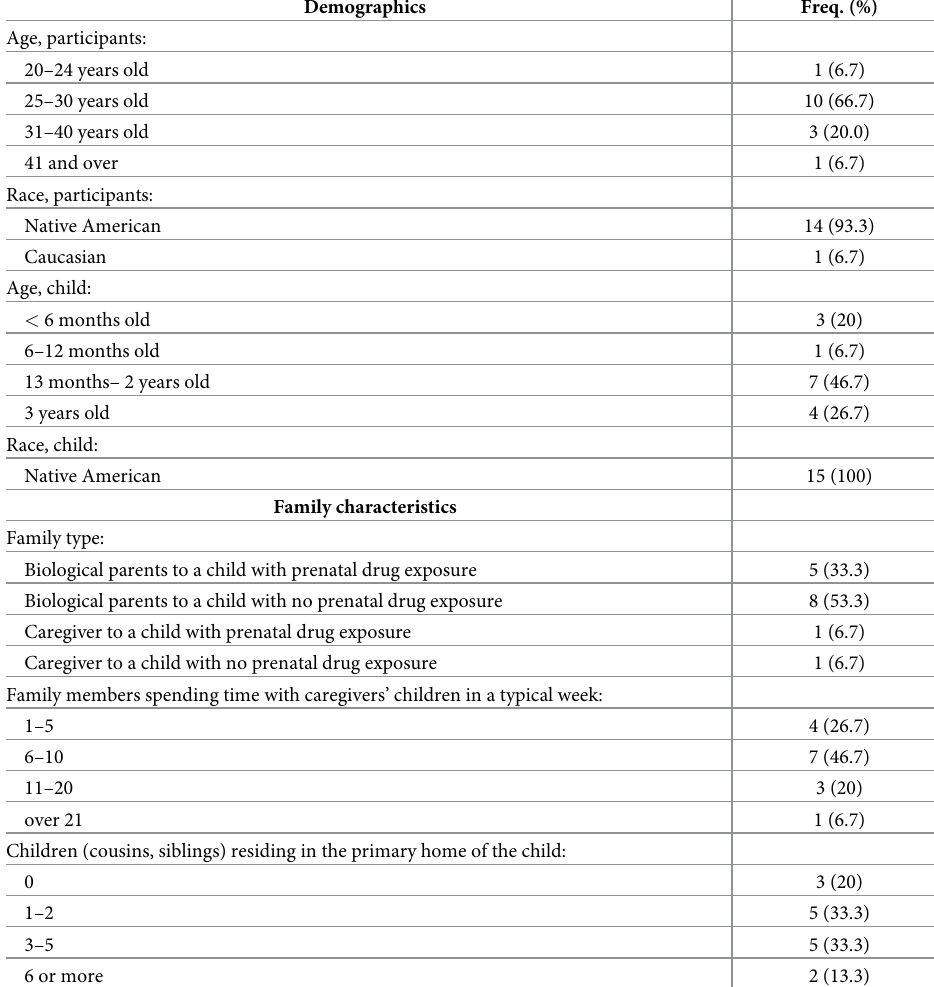
Table 1. Demographic and family characteristics of participants in one Tribal Nation, 2019 ( n =